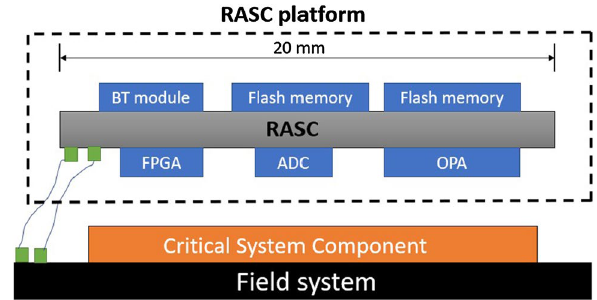
Fig. 1 Depiction of RASC being deployed in the field. RASC is a small PCB board that contains chips for signal processing, computation (FPGA), communication (Blue- tooth), and memory (Flash). RASC measures the IoT/CPS